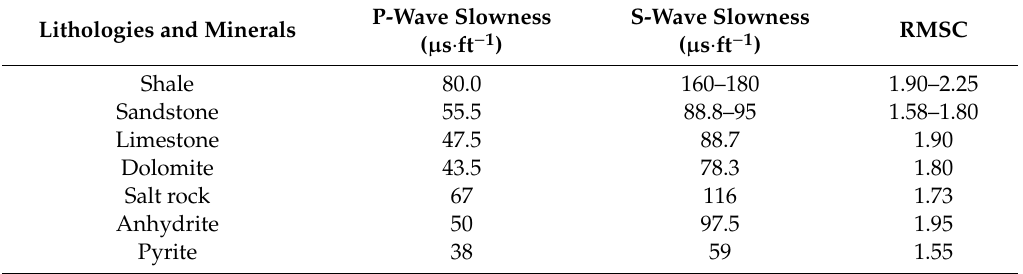
Table 1. The S-P wave slowness ratios (RMSCs) for the main lithologies and minerals [15,19–22]. P-Wave Lithologies and Minerals